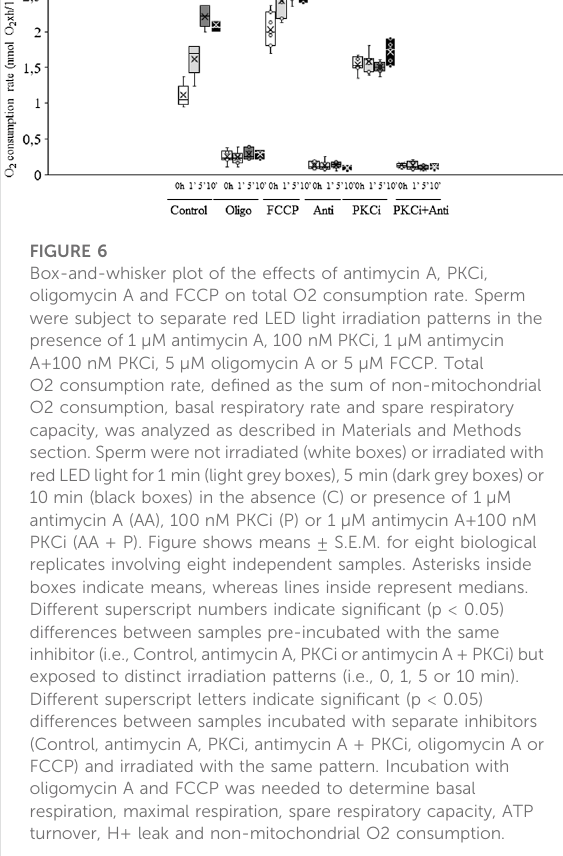
(Figure 6). Pre-incubation with PKCi signi fi cantly ( p < 0.05) increased O 2 consumption rate in non-irradiated samples (PKCi: 1.54 nmol O 2 ×h/10 6 viable sperm±0.04 nmol O 2 ×h/10 6 viable sperm vs. control: 1.11 nmol O 2 ×h/10 6 viable sperm±0.06 nmol O 2 ×h/10 6 viable sperm; Figure 6). Pre-incubation with PKCi,